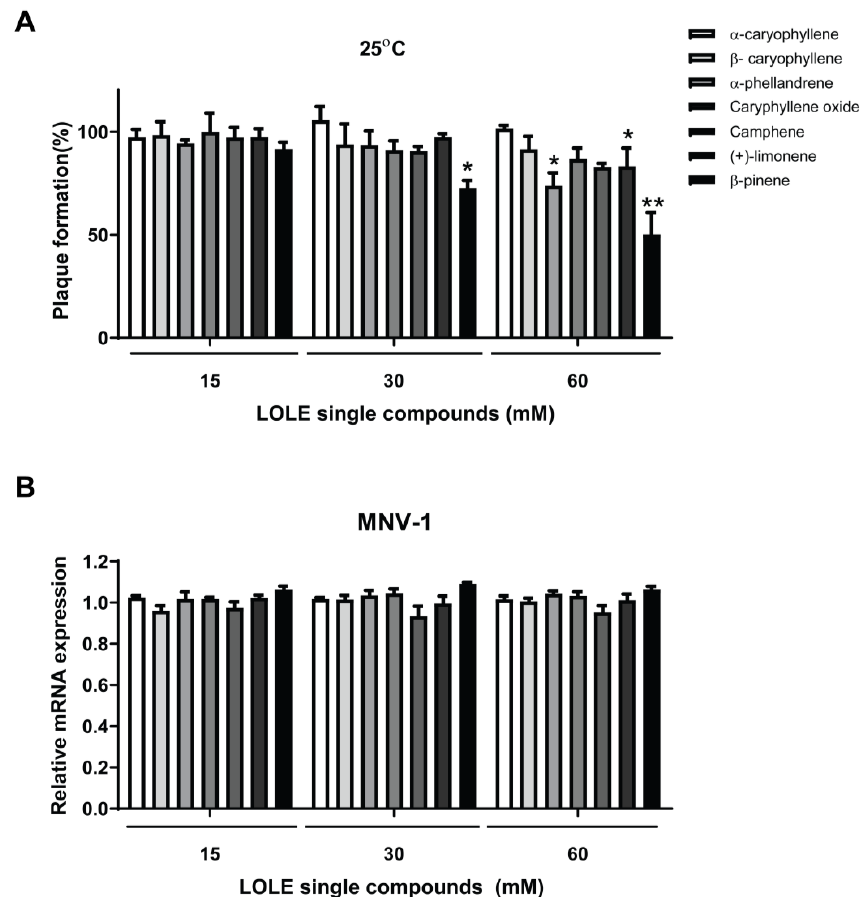
Figure 3. Anti-noroviral activity of Lindera obtusiloba leaf extract (LOLE) single compounds against Figure 3 murine norovirus (MNV-1). MNV-1 virus particles were preincubated with 15, 30 and, 60 mM LOLE solutions for 1 h at 25 ◦ C before infection of RAW 264.7 cells. ( A ) The e ff ect on plaque formation (%) of LOLE compounds was evaluated by plaque reduction assays. MNV-1 infectivity was calculated as a percentage of plaque formation using a dimethyl sulfoxide (DMSO)-treated control as a reference. ( B ) Quantification of viral mRNA of MNV-1 in infected RAW 264.7 cells. Gene expression is shown as fold-change relative to the expression in control (glyceraldehyde 3-phosphate dehydrogenase; GAPDH). The white bars represent the control groups, whereas the gray bars represent the intervention groups. Results are expressed as the percentage of neutralized virus compared to control (mean ± SEM; n = 3). * p < 0.05, ** p < 0.01 vs.